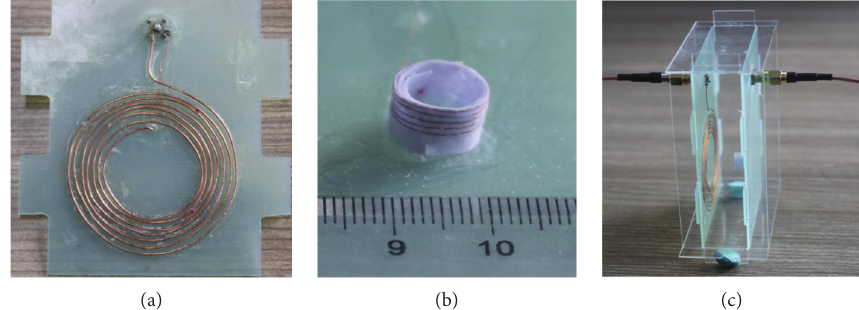
Figure 11: (a) The detailed view of a planar spiral Tx coil. (b) The cm-sized Rx coil. (c) Inductive link measurement setup with Rx coil in air environments. The Tx and Rx coils are supported by FR4 PCBs and Plexiglas flame and connected to a vector network analyzer by the SMA